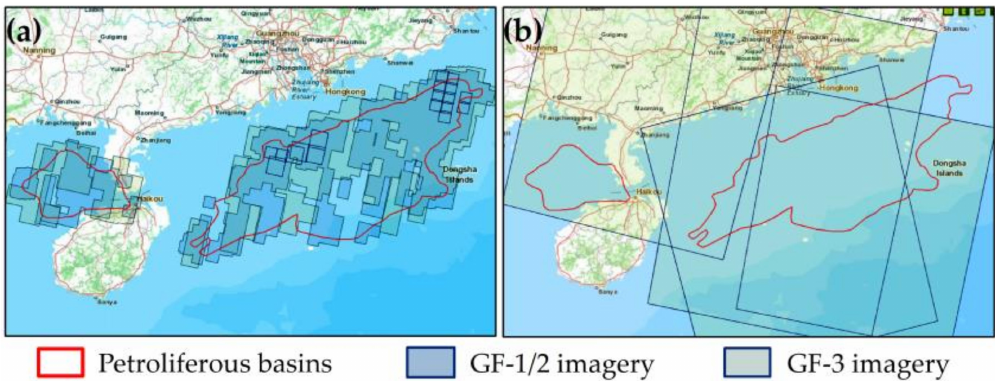
Figure 6. The image coverage of the study area. ( a ) shows the coverage of the GF-1/2 image and ( b ) shows the coverage of the GF-3 image.